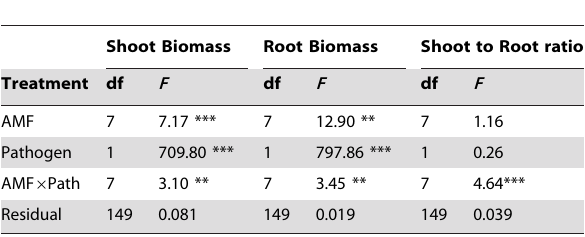
Table 3. ANOVAs of shoot and root